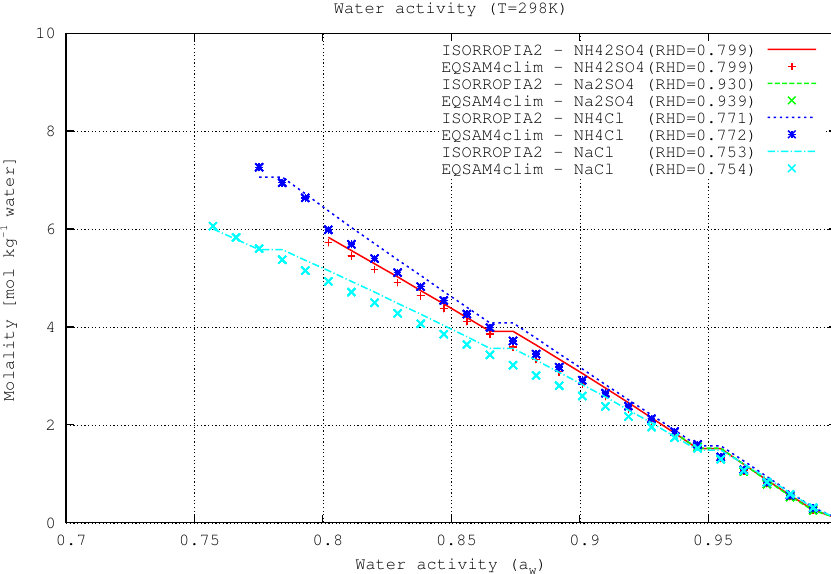
Figure A2. Figure A1 continued for (NH 4 ) 2 SO 4 , Na 2 SO 4 , NH 4 Cl, NaCl (at T = 298 . 15K).